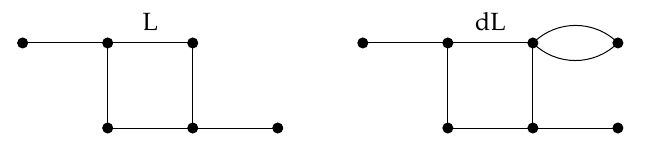
Figure 10. Alphabet letters describing